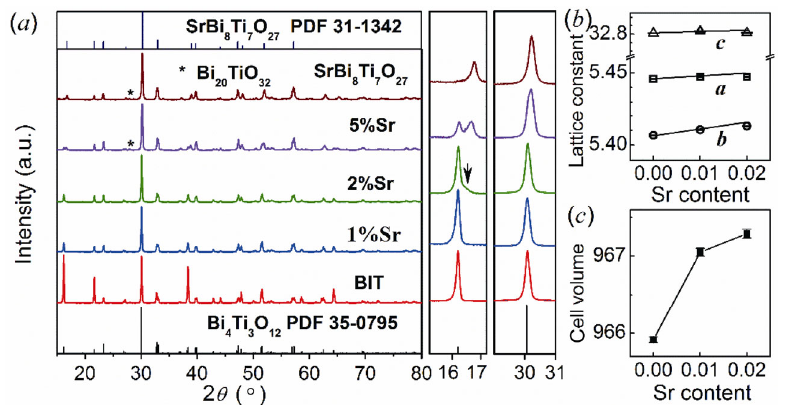
Fig. 1 (a) XRD patterns of SBIT ceramics with different compositions and enlarged parts around 16.2° and 30°; (b) lattice constants of different Sr contents; (c) cell volumes of different Sr contents.